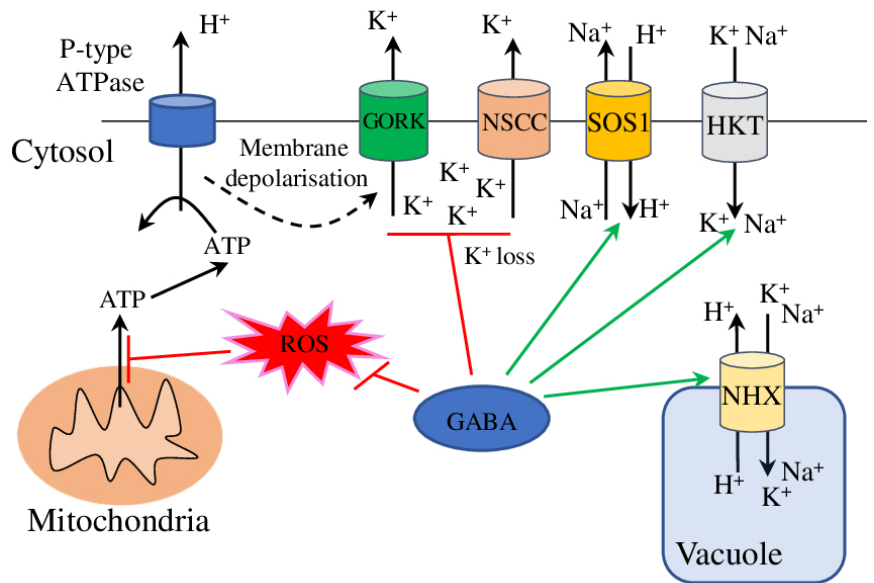
Figure 4. Integrative scheme of the role of GABA in the regulation of ion homeostasis. Red lines and green arrows represent the negative and positive effects, respectively, of GABA application on transporters and ion channels, their enzyme activity, and gene transcription.